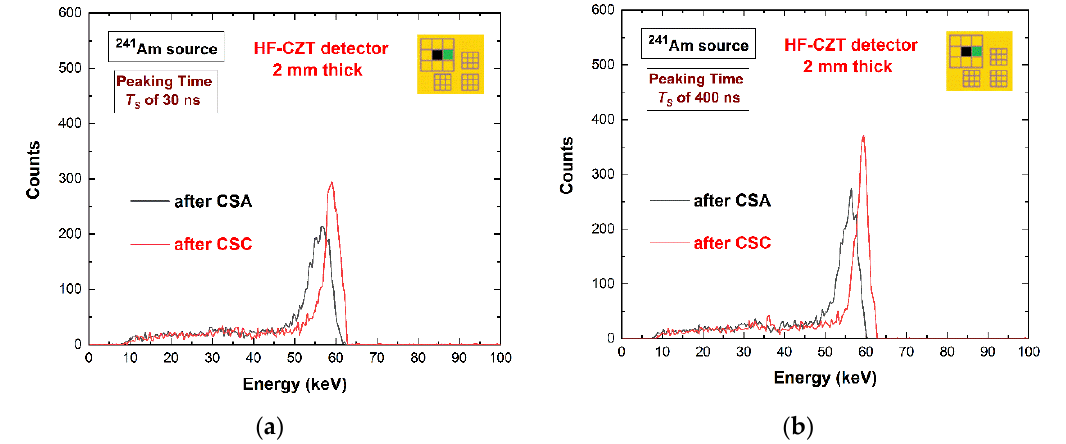
Figure 11. The energy spectra after CSA (black line) and after CSC (red line). ( a ) Ballistic deficit pulse processing; ( b ) energy resolution pulse processing.